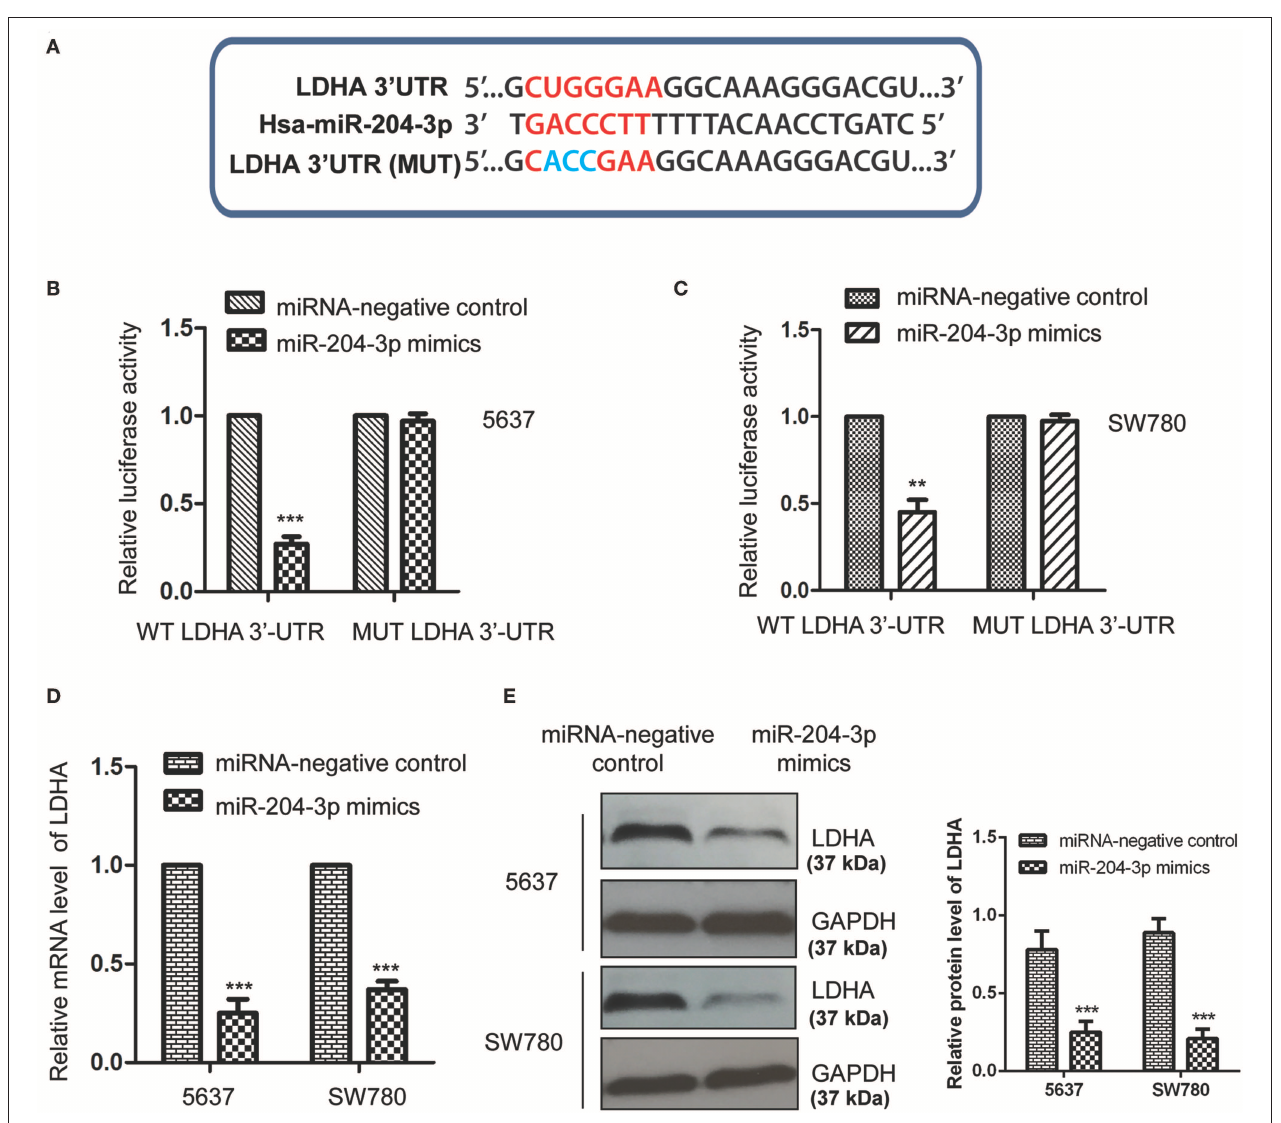
FIGURE 3 | MiR-204-3p targeted LDHA in bladder cancer cells. (A) The complementary sequences in the 3 ′ -UTR of LDHA and miR-204-3p. (B,C) The effects of miR-204-3p on the luciferase activity of wild-type or mutant LDHA 3 ′ -UTR were determined by luciferase reporter assay. (D,E) The effects of miR-204-3p overexpression on the mRNA and protein levels of LDHA in both SW780 and 5637 cells were validated by RT-qPCR and western blot assay, respectively. N = 3; ** P < 0.01 and *** P < 0.001. LDHA, lactate dehydrogenase; UTR, untranslated region; RT-qPCR, reverse transcriptase quantitative PCR. in the presence of high level of miR-204-3p ( Figure 4B